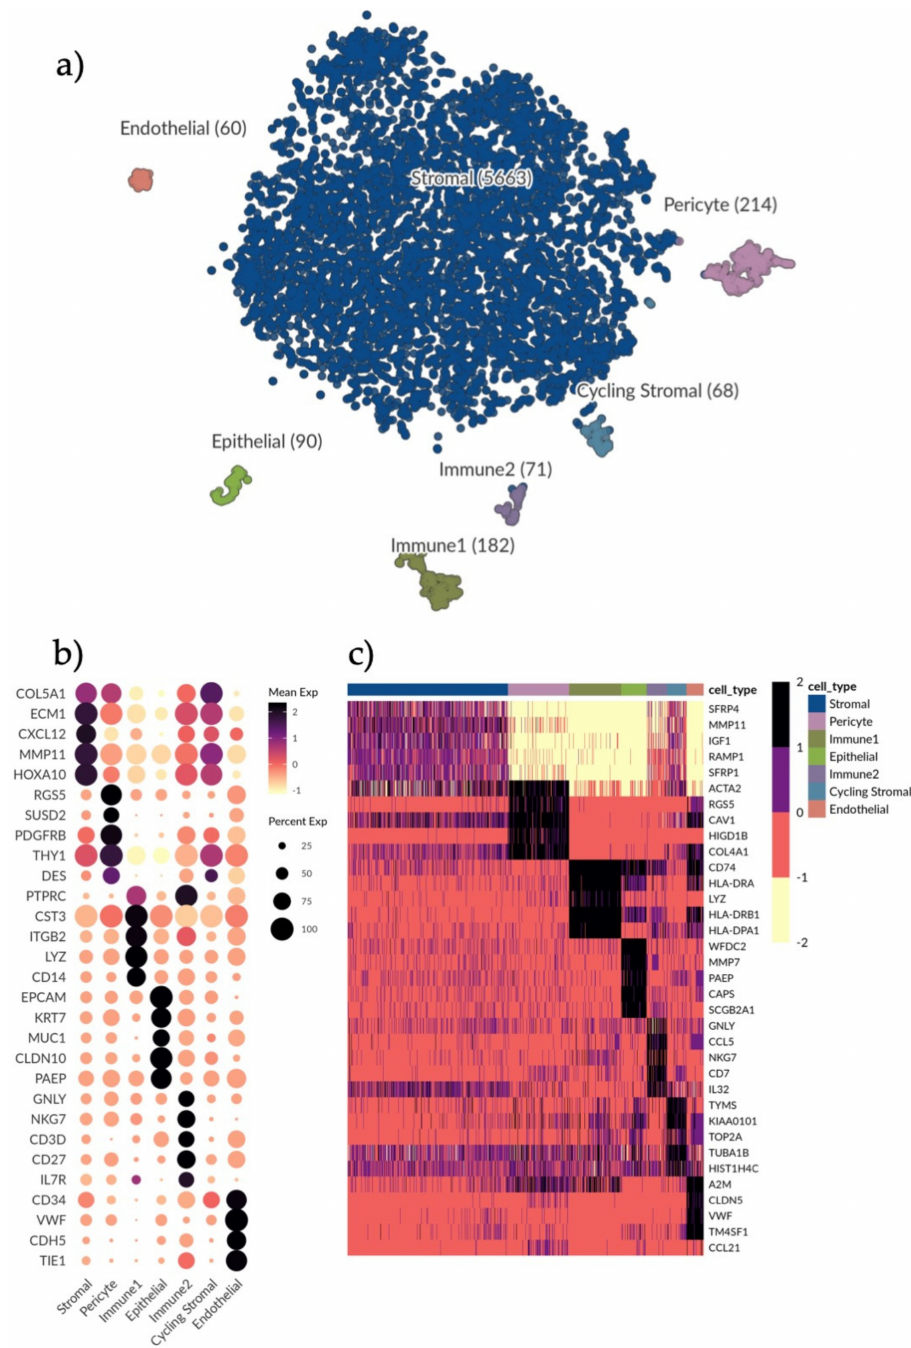
Figure 1. Single-cell clustering and identification of endometrial cells. ( a ) t-SNE plot visualizing clustering of scRNA-seq results from 6348 endometrial cells. Seven clusters were detected, namely, epithelial cells ( n = 90), endothelial cells ( n = 60), pericytes ( n = 214), immune1 ( n = 182), immune2 ( n = 71), stromal cells ( n = 5663) and cycling stromal cells ( n = 68). ( b ) Dotplot showing the gene expression of additional selected marker genes for each cell type to further identify clusters. Dots de- note mean normalized expression values over clusters. Immune1 displays a high expression of genes indicative of a monocyte phenotype, for example CD14 and LYZ. Immune2 displays an expression of CD27 indicating a T cell/NK cell phenotype. ( c ) Heatmap displaying the top differentially expressed genes (rows) for each cell type (columns) based on the MAST test with a minimum log fold change of 2 and adjusted p -value of 0.05. Color scale is clipped at